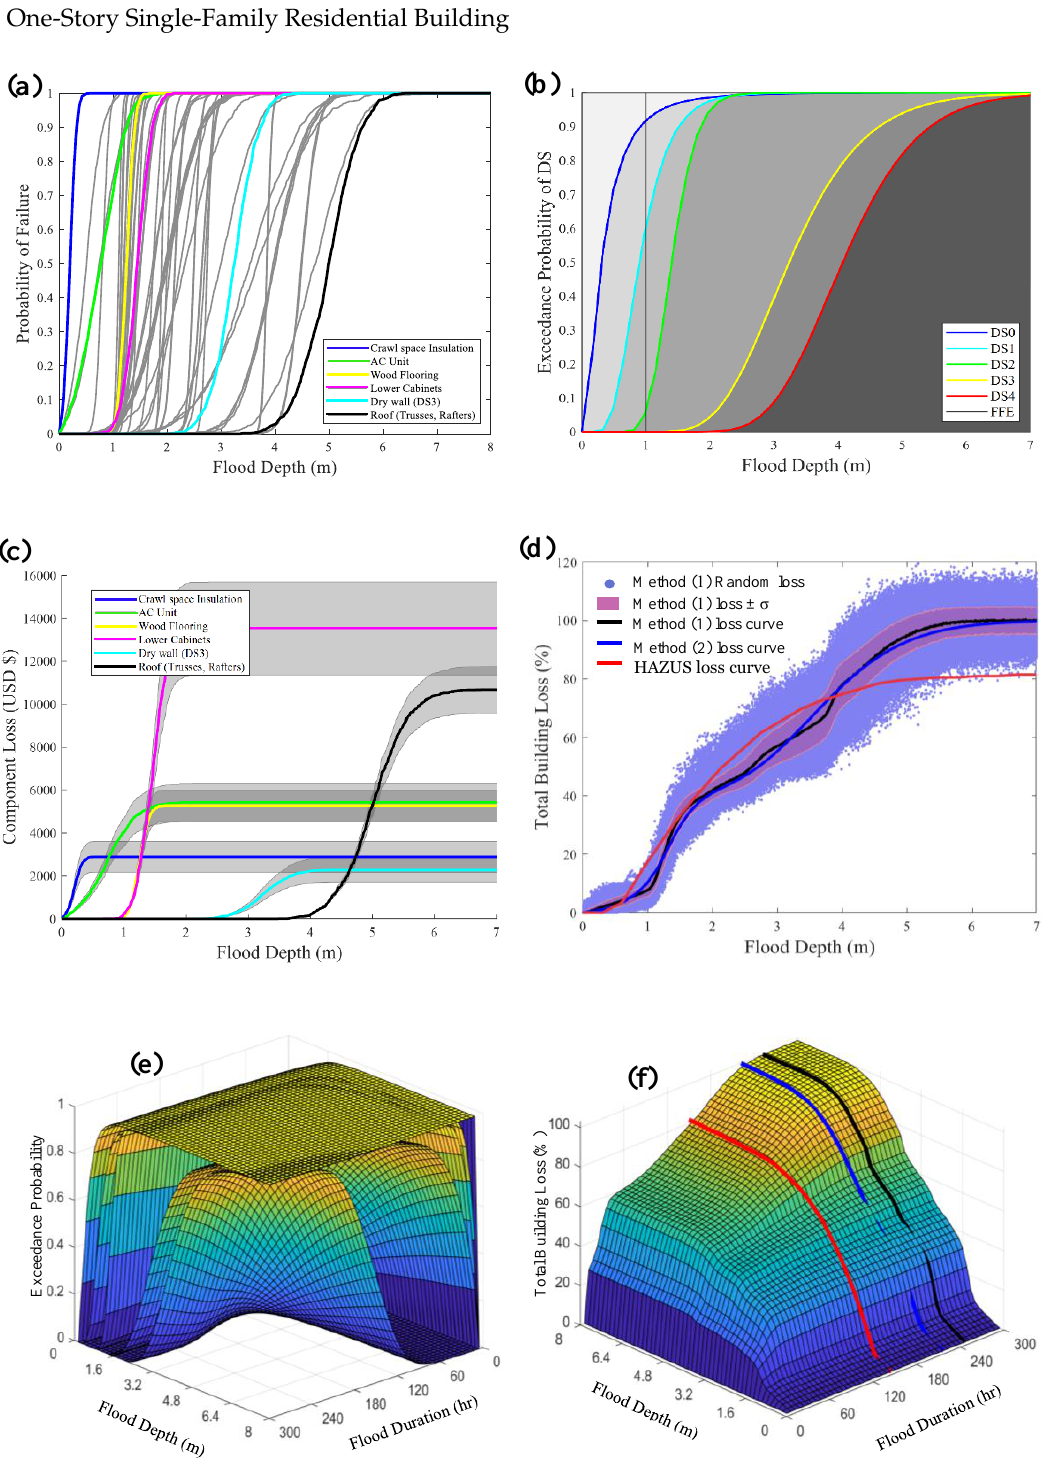
Figure A15. F1 archetype analysis results: ( a ) Component fragility curves; ( b ) Building fragility curves; ( c ) Selected components’ loss curves; ( d ) Building loss curves; ( e ) Building fragility surfaces; ( f ) Building loss surface.